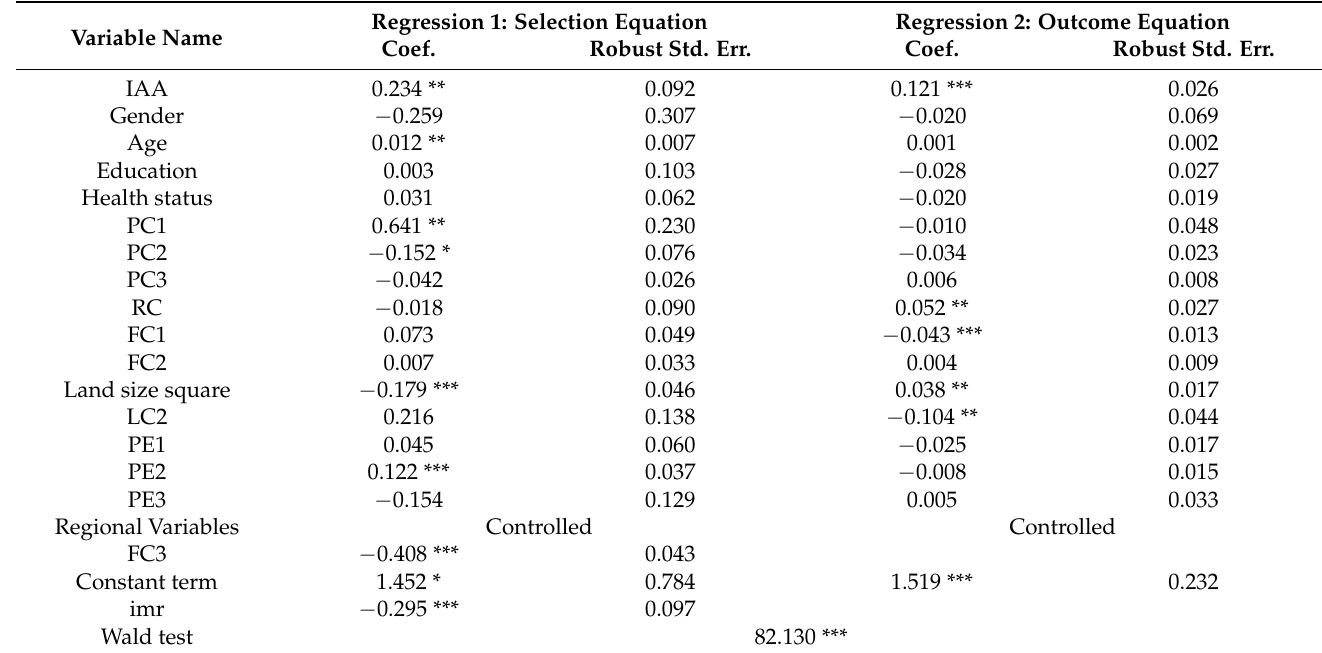
Table 5. Heckman model estimation